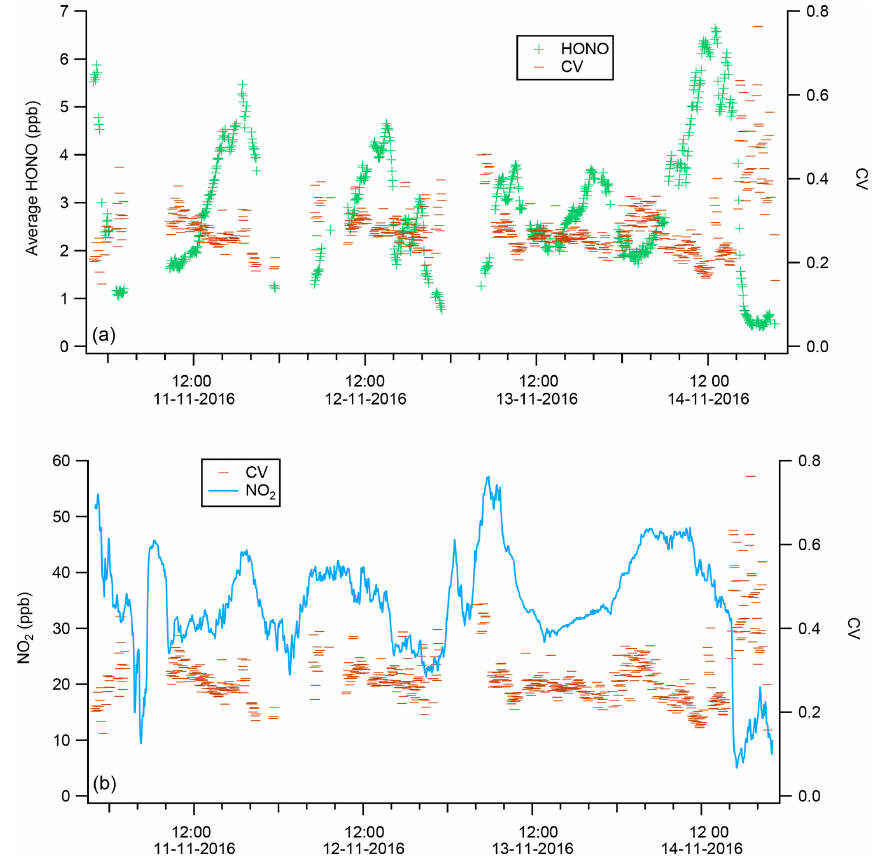
Figure 2. Time series of the coefficient of variance (CV), mean mixing ratio of HONO (a) and NO 2 (b) during the winter intercomparison. Time zone is local time, China standard time (CST). Note, only in the case in which all four instruments were measuring were the mean HONO and the CV